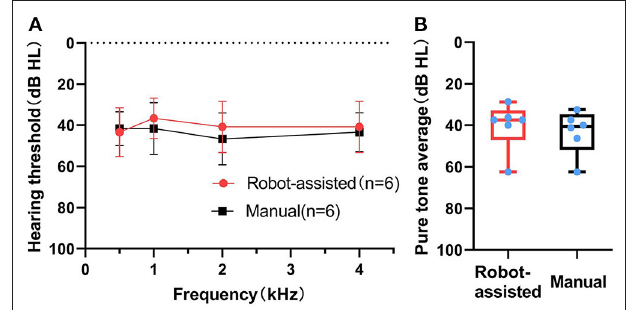
FIGURE 4 | (Behavior) Pure-tone audiometry with CI after 6–9 months. Pure tone audiometry (PTA) thresholds (A) and pure tone average (B) in the robot-assisted ( n = 6) and manual insertion ( n = 6) groups 6–9 months after first